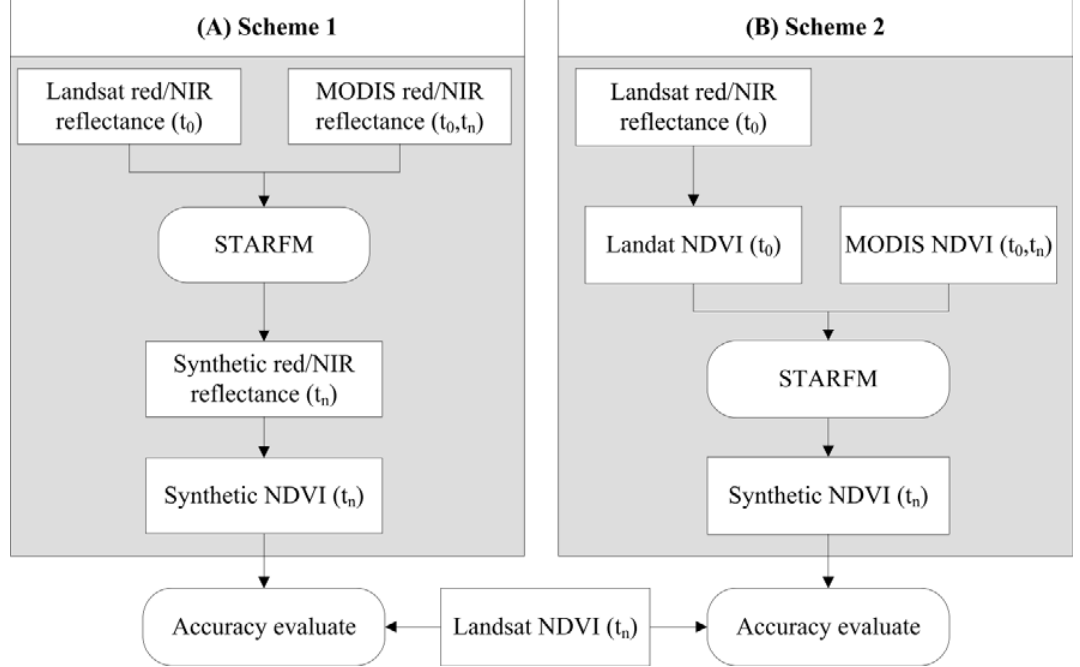
Figure 3. Two schemes for generation of synthetic Normalized Difference Vegetation Index (NDVI) images using Spatial and Temporal Adaptive Reflectance Fusion Model (STARFM). t represents the day on which base pair Landsat and Moderate Resolution 0 Imaging Spectroradiometer (MODIS) images were obtained; t synthetic image was produced.